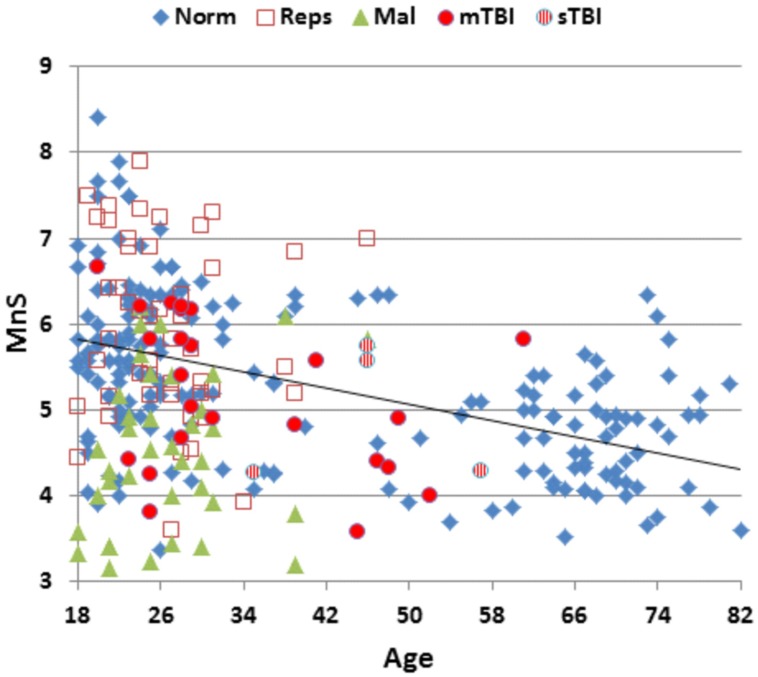
Mean spatial span (MnS) of participants as a function of age. For control participants in the normative dataset (Norm.), participants in Experiment 1a (Reps), malingering participants (Mal, Experiment 2), and mild and severe TBI (mTBI and sTBI) patients (Experiment 3).